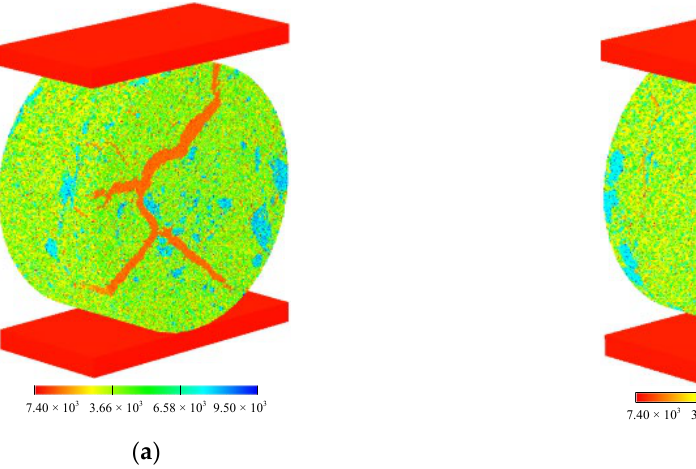
Figure 8. Mesoscale shale CT image. ( a ) Three-dimensional CT model. ( b ) Single CT image. ( c ) CT image after threshold segmentation ( organic matter, clay minerals, carbonate minerals).